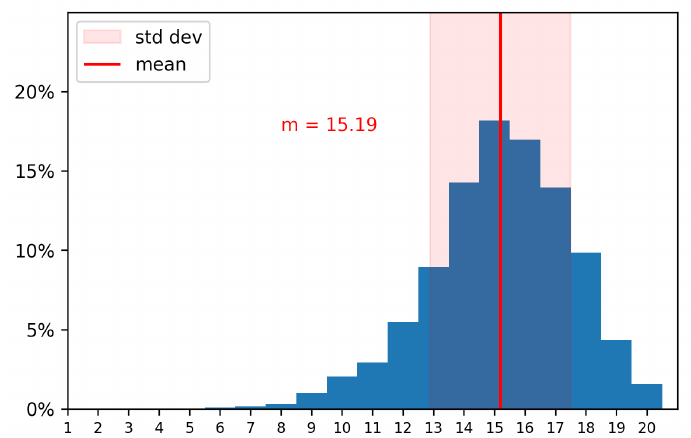
Figure 10. Distribution of scores for those users that opened another tab during the test and returned to the test a while after at least once. Actually, the score’s average is higher here than the overall outcomes (see Figure 10). Tab opening could be an indicator of online